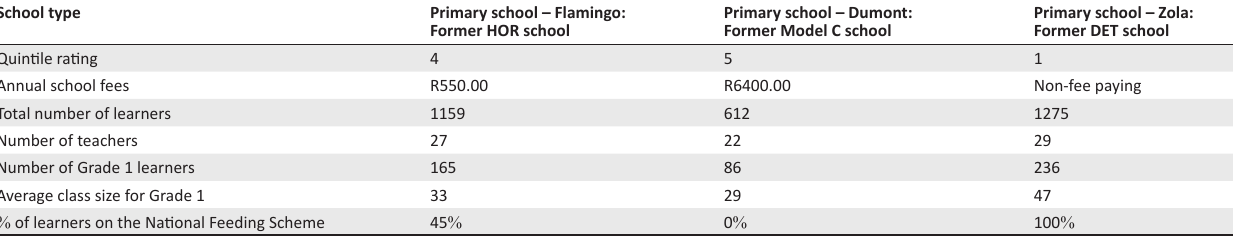
TABLE 1: Overview of the main features of the three selected primary schools. School